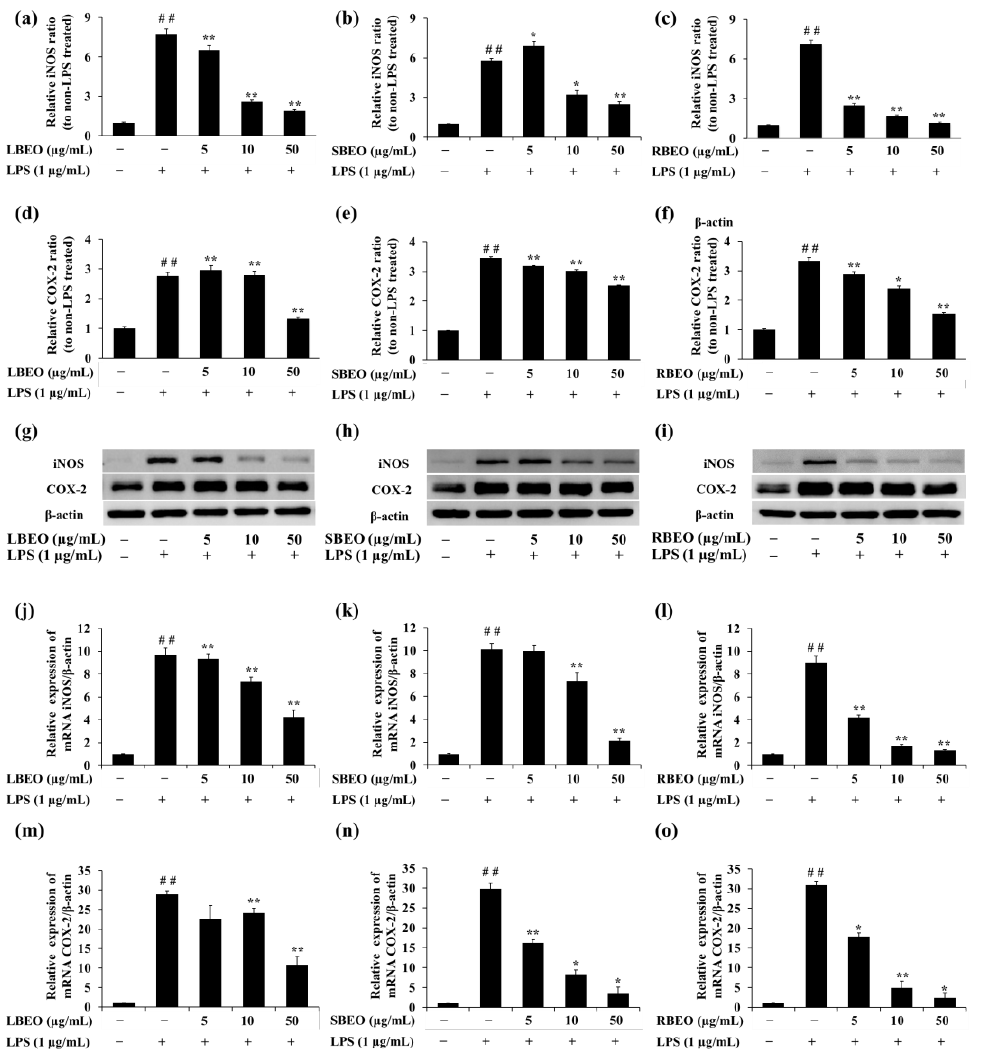
Figure 6. Inhibitory effects of BEOs on iNOS and COX-2 expression in RAW 264.7 macrophages. The iNOS and COX-2 protein levels in ( a , d , g ) LBEO-, ( b , e , h ) SBEO-, and ( c , f , i ) RBEO-pre-treated cells were assessed using Western blotting after 24 h LPS induction. The iNOS and COX-2 mRNA expression levels in ( j , m ) LBEO-, ( k , n ) SBEO-, and ( l , o ) RBEO-pre-treated RAW 264.7 cells were quantified using qRT-PCR after 24 h LPS induction. The β -actin mRNA level was used to normalize the data. The results were compared to those in the untreated cells. Results are shown as mean ± SD ( n = 3). ## p < 0.01 vs. the LPS-untreated cells; * p < 0.05, ** p < 0.01 vs. the LPS alone-treated cells.